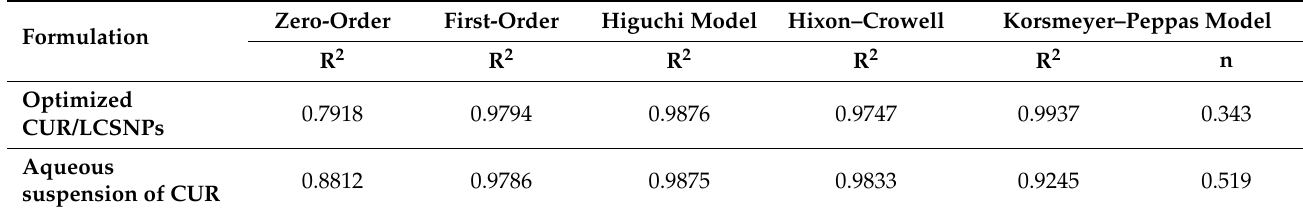
Table 6. Kinetic modeling of CUR release from the optimized CUR/LCSNPs.